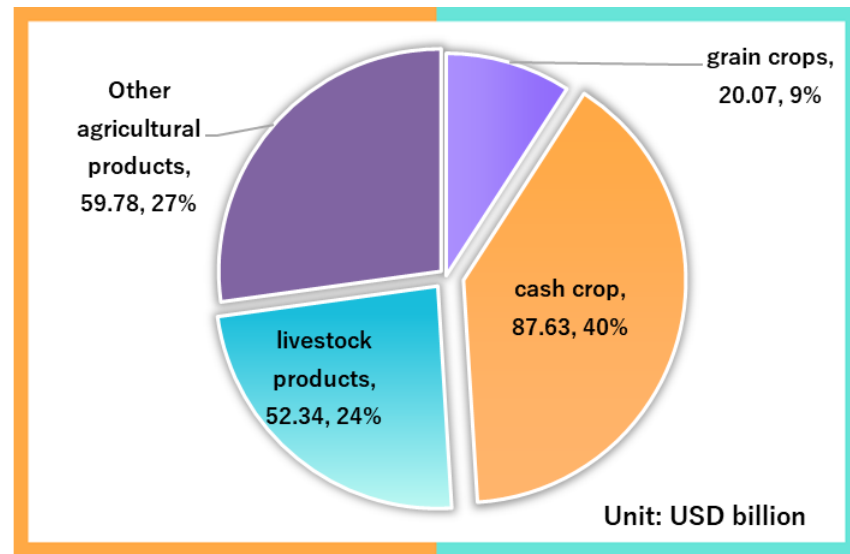
Figure 2. China’s agricultural product imports in 2021.